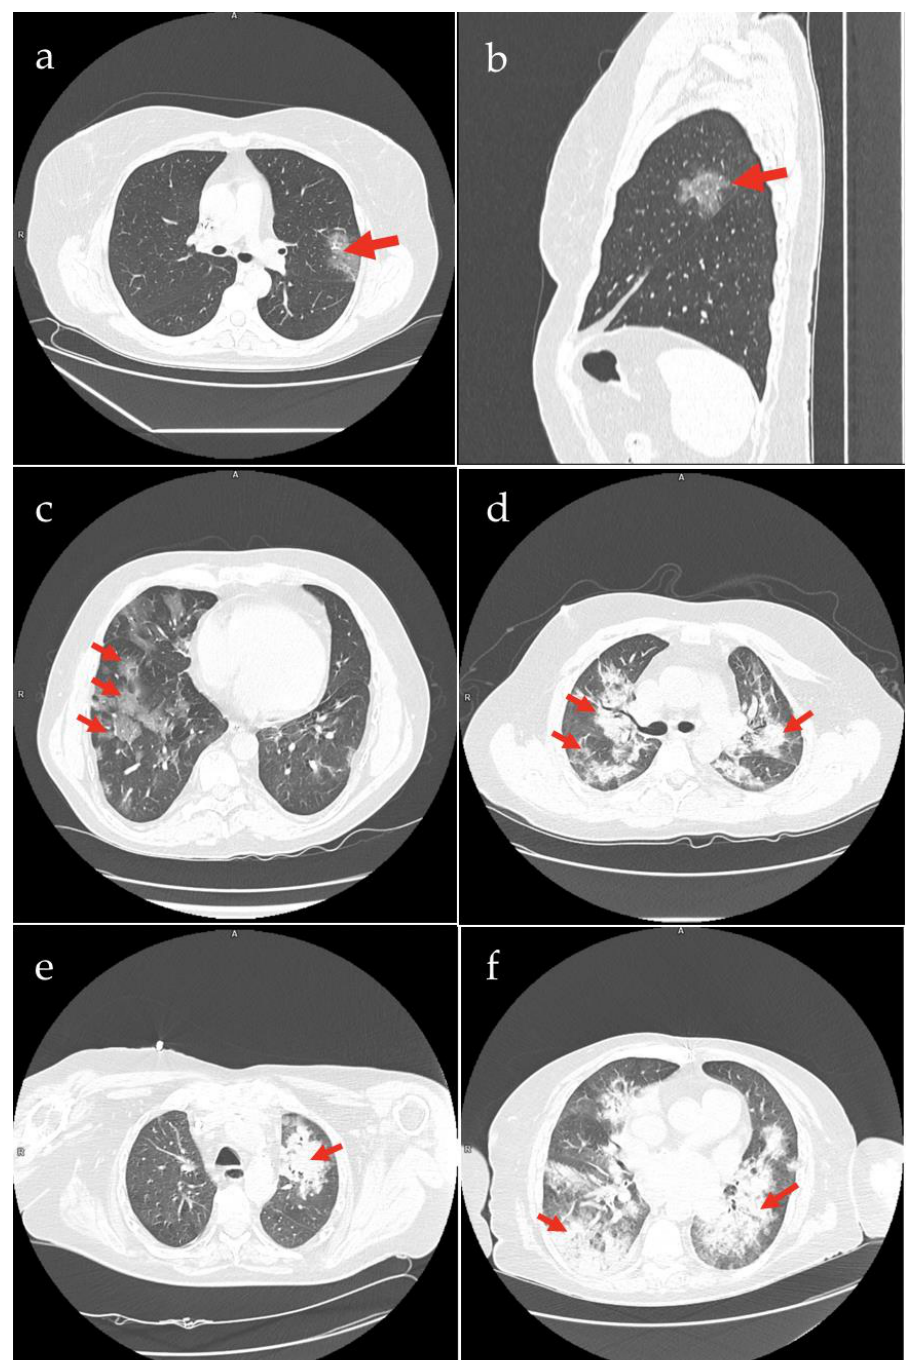
Figure 1. Representative chest CT images with pathological changes (red arrows) from our cases: ( a , b ). ground-glass opacity in the upper lobe of the left lung; ( c ). multifocal changes of ground-glass opacity with a crazy-paving pattern symptom; ( d ). peribronchial, bilateral opacities of organizing pneumonia with air bronchogram ( e ). unilateral consolidations; ( f ). bilateral consolidations.